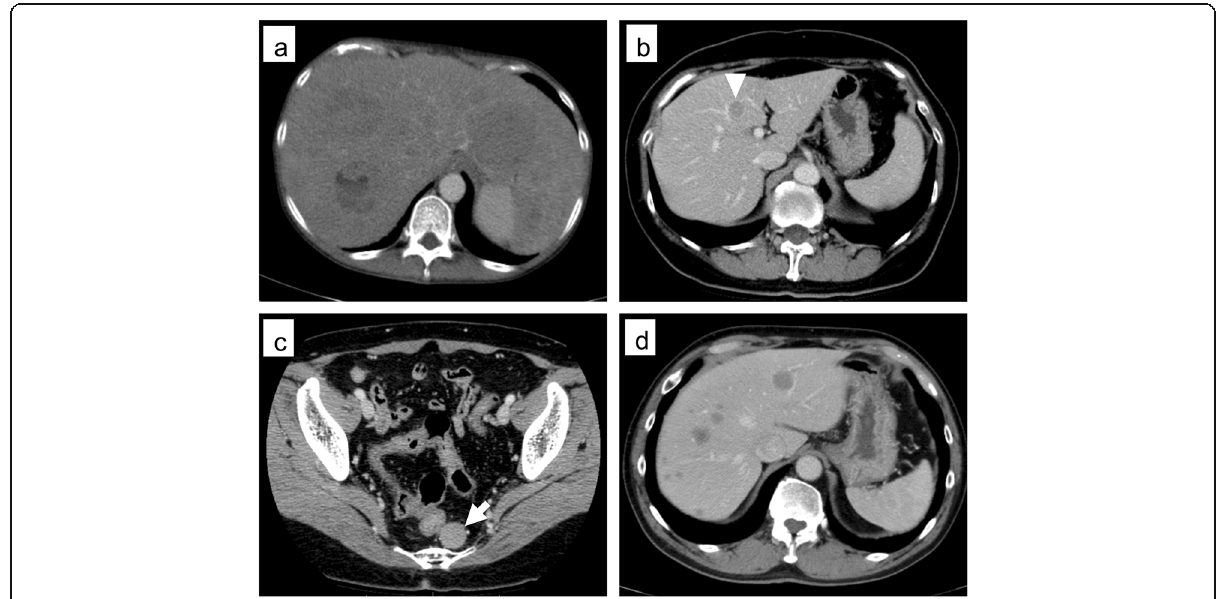
Fig. 2 Selected images from abdominal computer tomography. a Case 1: multiple low-density lobular lesions in the bilateral lobe. b Case 2: low- density lesion in S4 (arrowhead). c Case 2: left dorsal recurrent mass of the rectum (arrow). d Case 3: multiple low-density lesions in the bilateral